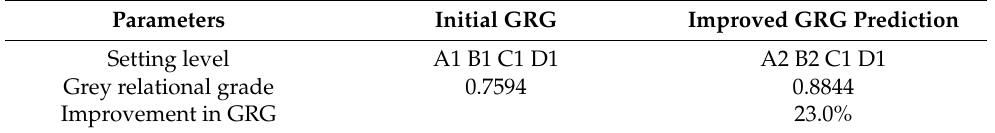
Table 14. Optimum GRG